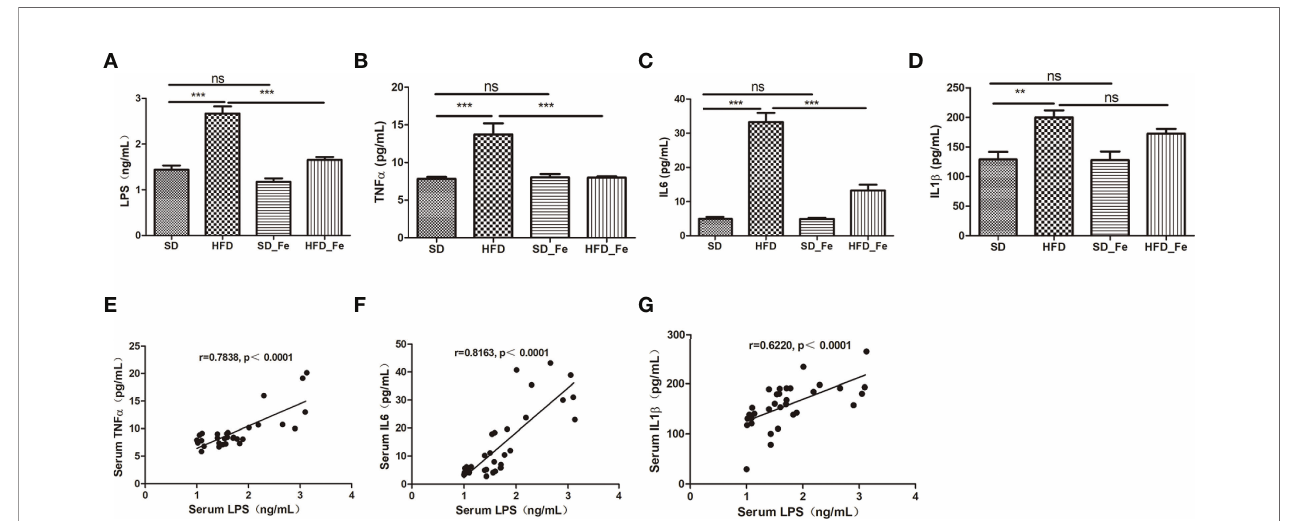
FIGURE 2 | Effect of feno fi brate on in fl ammatory factors in the serum of high-fat diet (HFD)-fed mice. (A – D) Serum LPS (A) , TNF a (B) , IL6 (C) and IL1 b (D) levels in the four groups. (E – G) Correlations between LPS and in fl ammatory factors TNF a (E) , IL6 (F) and IL1 b (G) in the serum. When correlation coef fi cient “ |r| ” ≥ 0.349 (n = 32) and p < 0.05, there were signi fi cant correlations between the two indicators. SD group, standard diet group; HFD group, high-fat diet group; SD_ Fe group, standard diet plus feno fi brate group; HFD_ Fe group, high-fat diet plus feno fi brate group. n = 8 (A – D) ; ns, not signi fi cant; **P < 0.01; ***P < 0.001. Bar graphs represent mean values ±